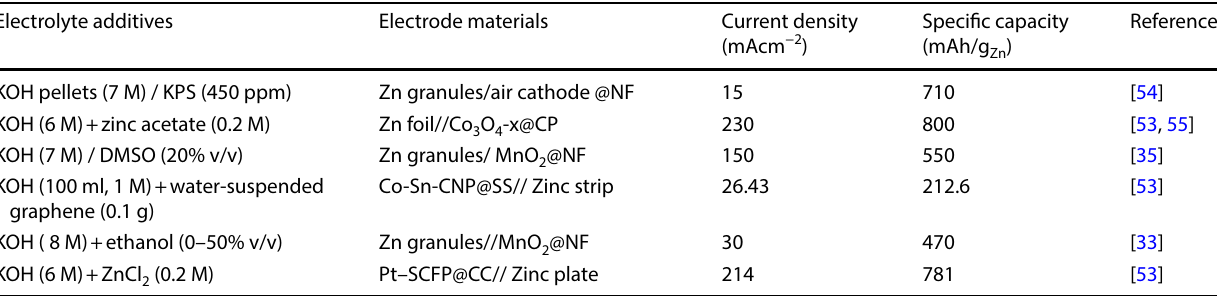
Table 5 Summary of the alkaline electrolyte additive for ZABs